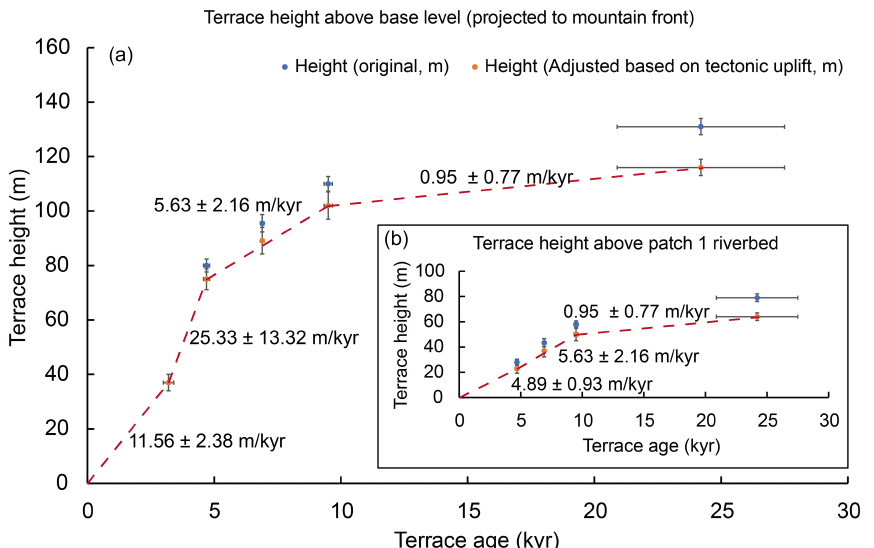
Figure 6. (a) Terrace height above base level and the incision rate of each stage at the mountain front. (b) Terrace height and incision rate of each stage above patch 1, upstream of the knickpoint. Details of elevations with correction for tectonic uplift are in Table 4.